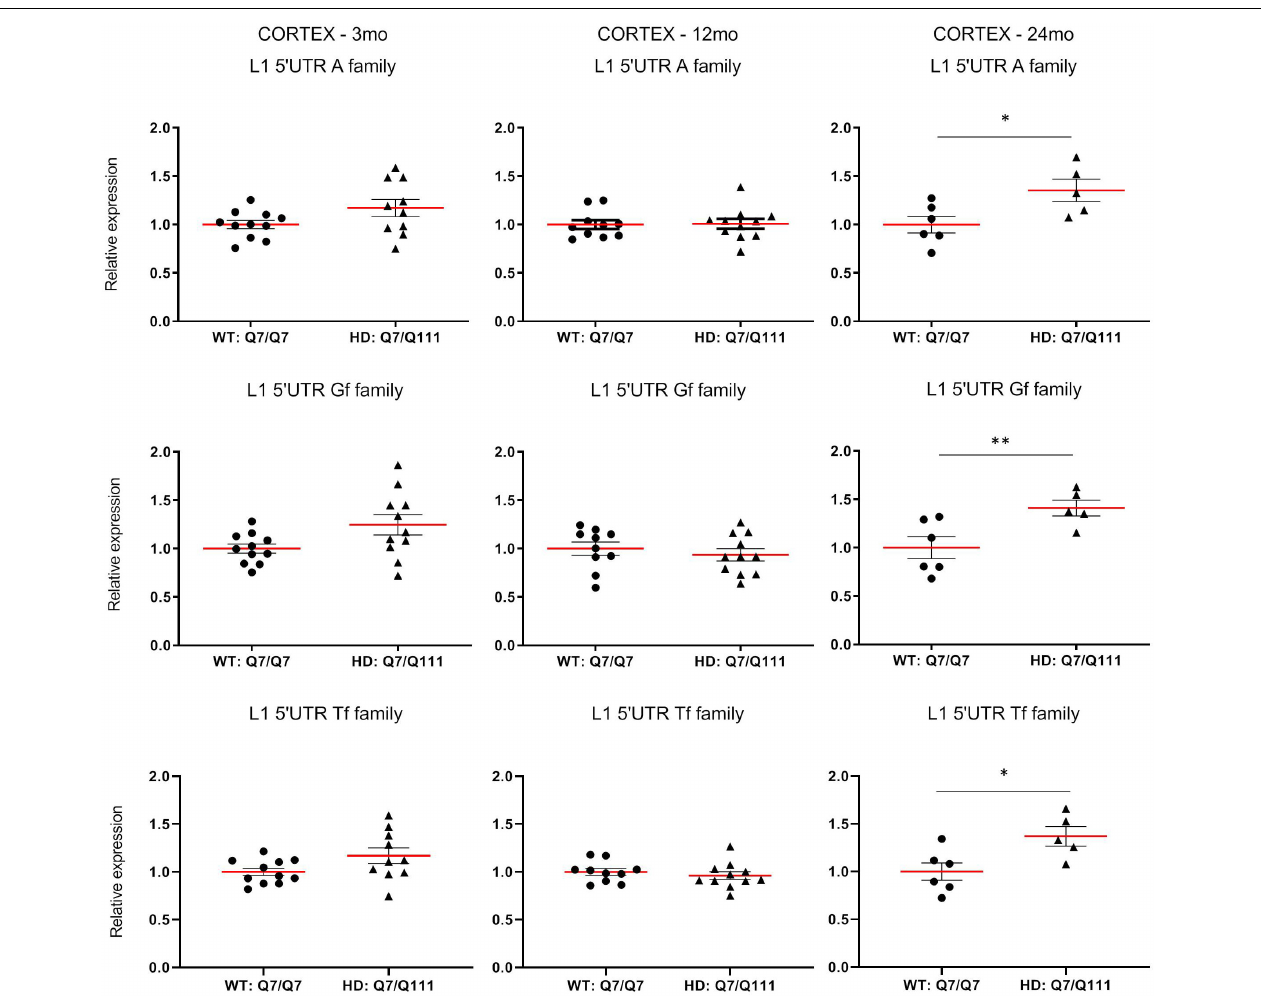
FIGURE 4 | Expression of full-length L1s mRNA in postnatal cortex of HD and WT mice. Relative quantification of L1 5 (cid:48) UTR mRNA levels in the cortex of WT: Q7/Q7 and HD: Q7/Q111 mice at 3, 12, and 24 mo of age. Relative L1 5 (cid:48) UTR expression levels are normalized with the housekeeping gene UbC. Each dot results from 3 independent qPCR replica on each sample. Mean value is shown with red bar. Error bars indicate SEM. ∗ P < 0.05, ∗∗ P < 0.01 resulting from Mann Whitney unpaired test. Groups for 3 and 12 mo mice are composed by 12 biological replicates ( n = 12). Groups for 24 mo mice are composed by 6 biological replicates ( n =